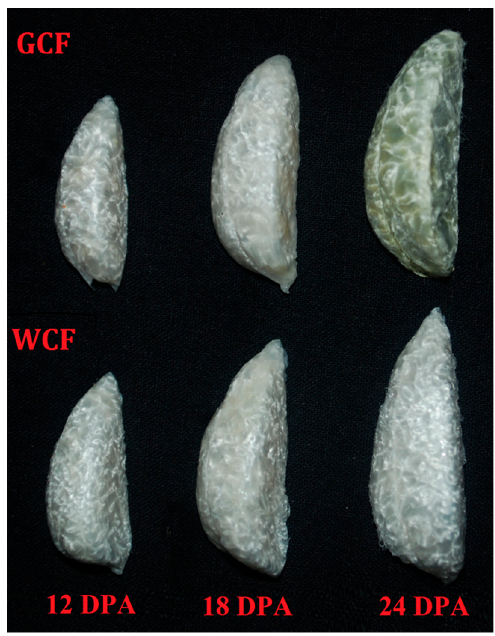
Figure 7. Fiber phenotypes of the green-colored fibers (GCF) and white-colored fibers (WCF) at 12, 18, and 24 days post-anthesis (DPA).